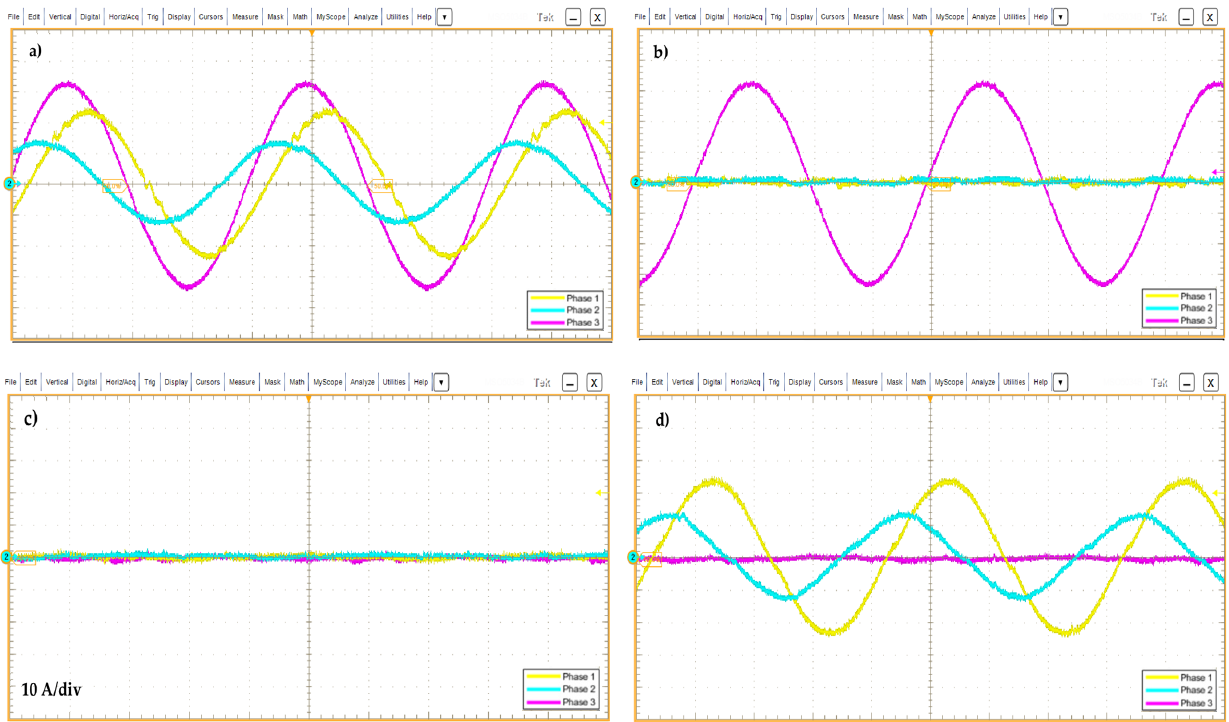
Figure 13. Programmable AC source currents (measured at PCC point): ( a ) AC source loaded without AC/DC converter connected, ( b ) connected AC/DC converter operating in reactive power compensation mode, and ( c ) reactive power compensation in the idle state of the AC current source. ( d ) The reactive current flow forced by the converter AC/DC.